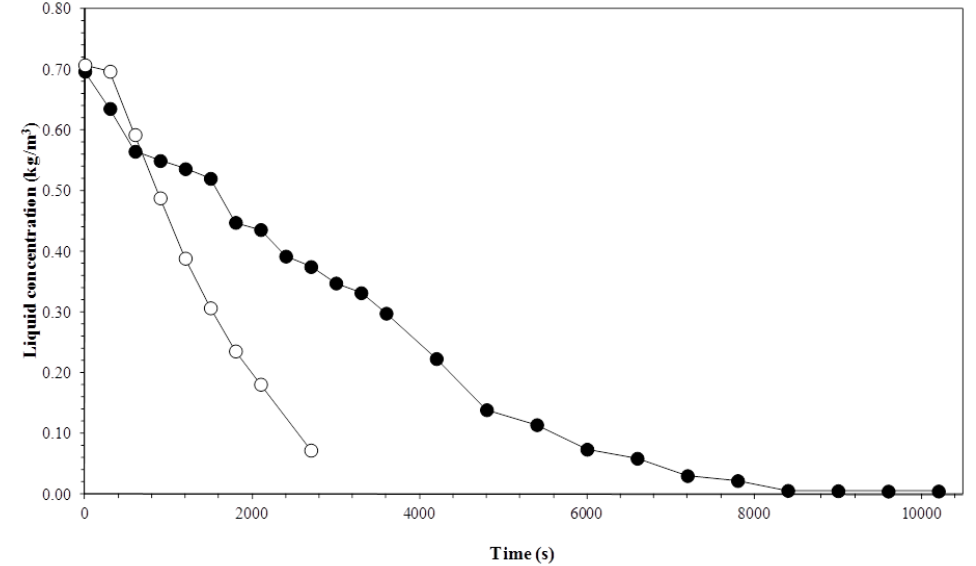
Figure 4. Variation in the liquid column concentration with time and gas flow rate. Experiment conditions: initial biosurfactant concentration of 0.7 kg m − 3 and temperature of 15 °C. Gas flow rate: ( ) 3.3 × 10 − 7 m 3 s − 1 ;